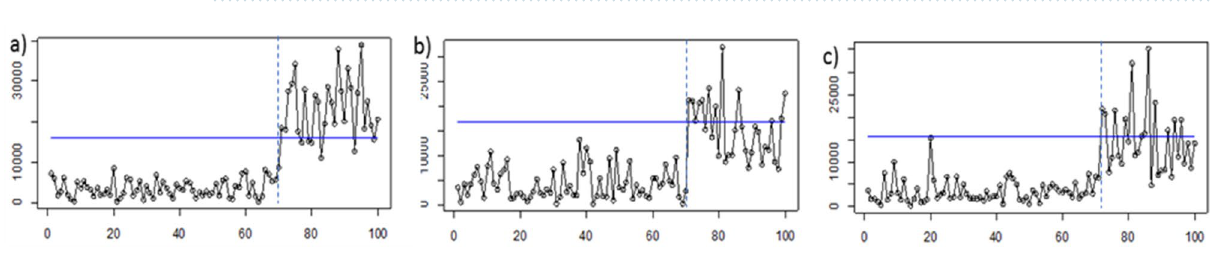
Figure 6. Application of the PCA Mix chart for: ( a ) the first scenario, ( b ) the second scenario, and ( c ) the third scenario.